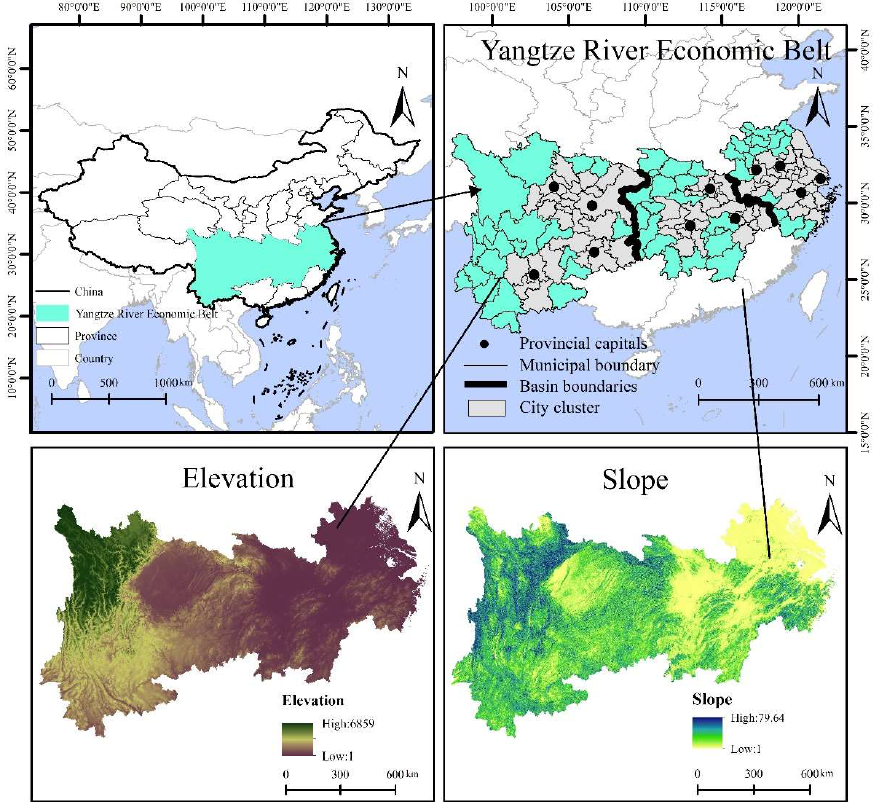
Figure 1. Altitude and slope map of the Yangtze River Economic Belt. Table 1. Classification of altitude and slope of the Yangtze River Economic Belt.